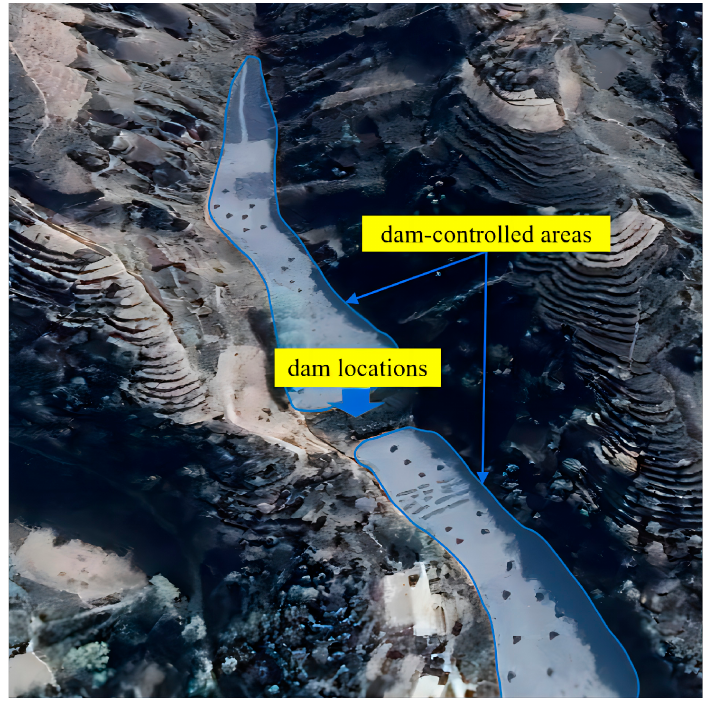
Figure 1. Check dam system in the Yellow River Basin.